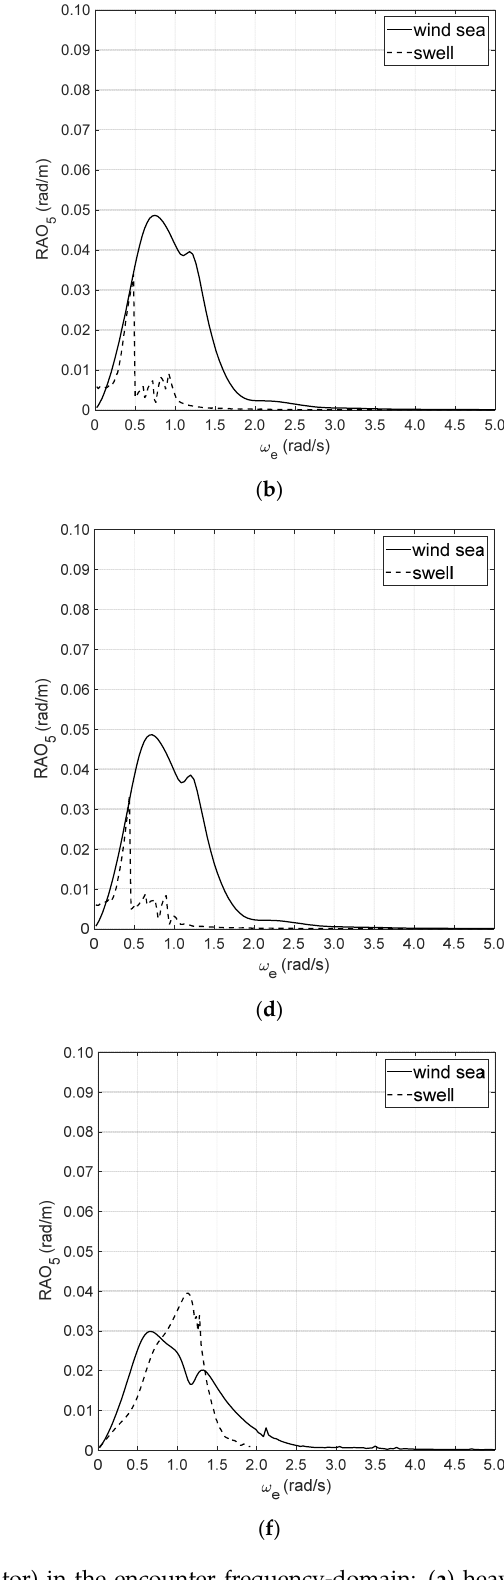
Figure 4. Heave and pitch RAOs (Response A mplitude O perator ) in the encounter frequency-domain: ( a ) heave—7